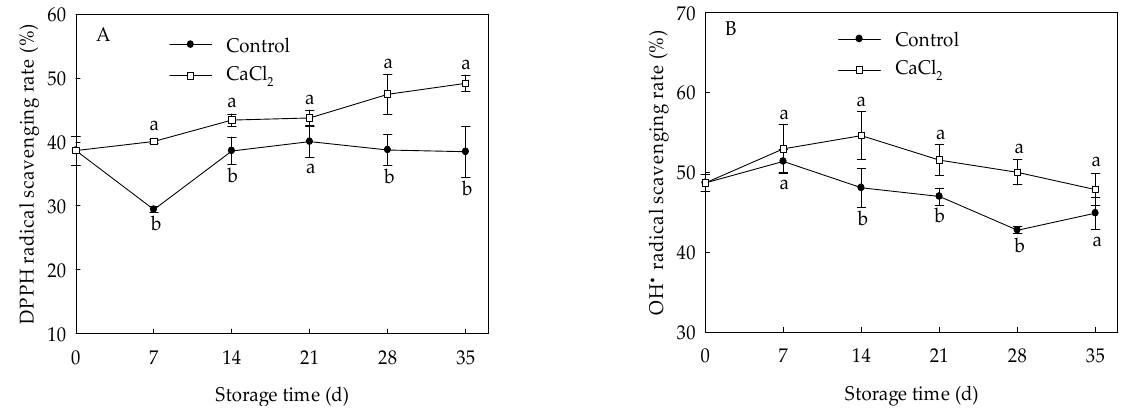
Figure 2. O •− generation rate ( A ) and H 2 O 2 content ( B ) in loquat fruit stored at 1 ◦ C after treatment with 1% CaCl 2 or water (control). Vertical bars indicate the SE of mean ( n = 3). The symbols a and b represent a significant difference in the two treatments ( p < 0.05).